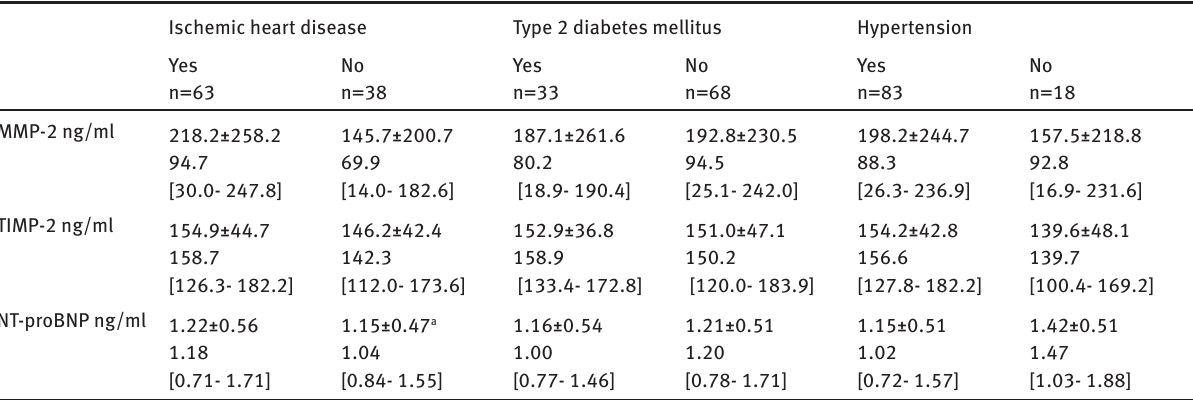
Table 4: The serum levels of MMP-2, TIMP-2 and NT-proBNP in HF patient subgroups by concomitant disease (ischemic heart disease, type 2 diabetes mellitus,